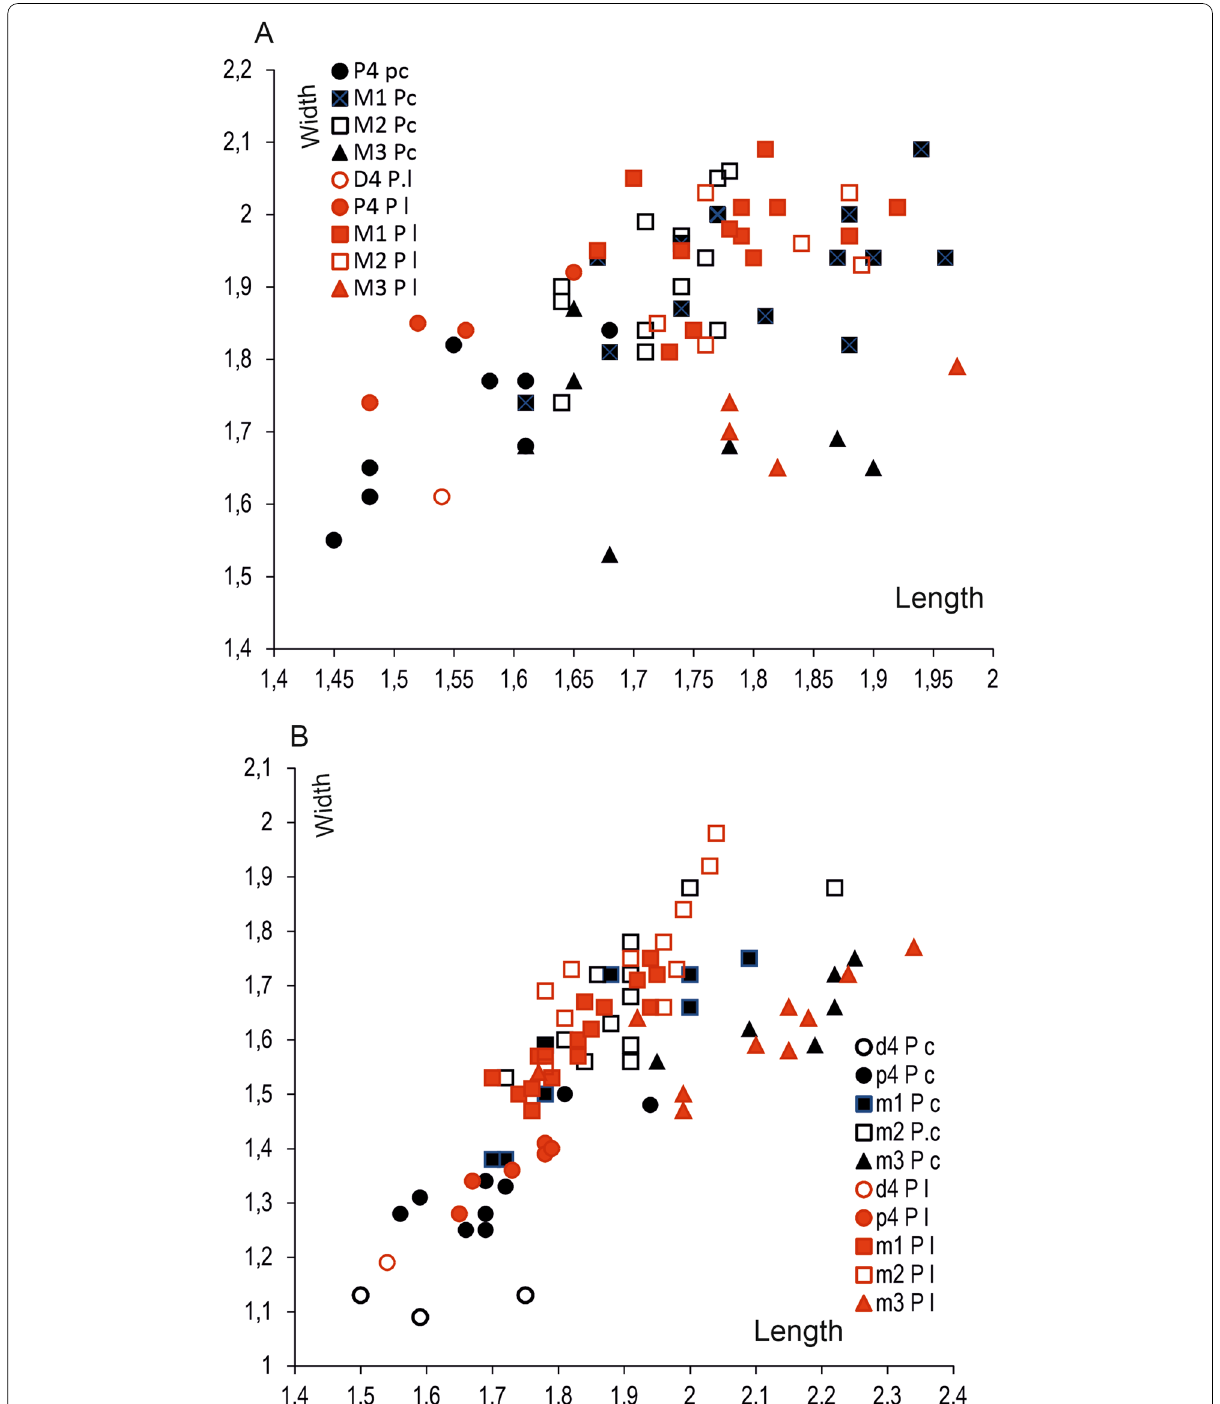
Fig. 14 Bivariate graph of the size (width/length) of the upper (A) and lower (B) teeth of Protadelomys lugdunensis Hartenberger, 1969 from Lissieu (Rhône) (red marks) compare to the size of the teeth of Protadelomys cartieri (Stehlin & Schaub, 1951), from Egerkingen (Swiss Jura) (black